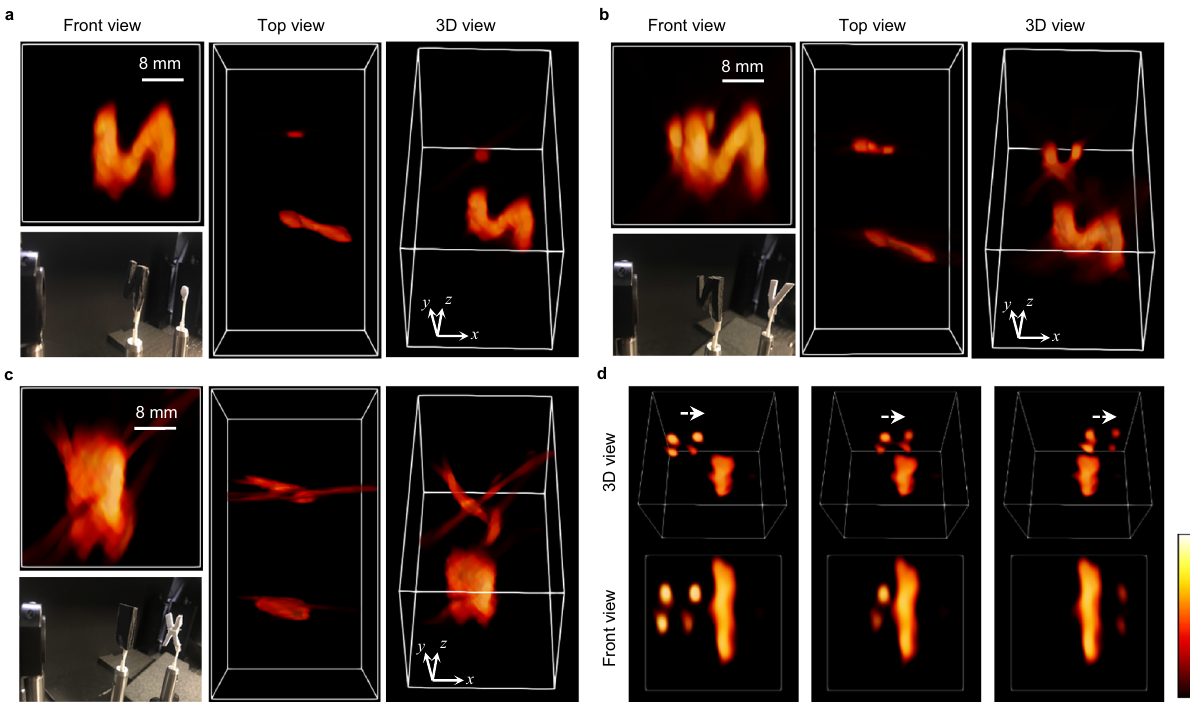
Fig. 2 Three-dimensional imaging (3D) through occlusions. a – c Reconstructed 3D images rendered in different perspective for three scenes: circular plate ( a ) and letter V ( b ) behind the letter N, and letter X ( c ) blocked by a rectangular plate. The severe occlusions are evident from the front view images, with the larger objects in the front completely blocked the object right behind them. In contrast, CLIP is able to unambiguously reconstruct the obstructed objects in 3D without any defocusing signals from the preceding occluder. d Three representative frames of imaging a 2 × 2 grid pattern moving across the CLIP camera FOV behind a rectangular occluder. Note that signals from the black occluders are enhanced relative to the objects for better